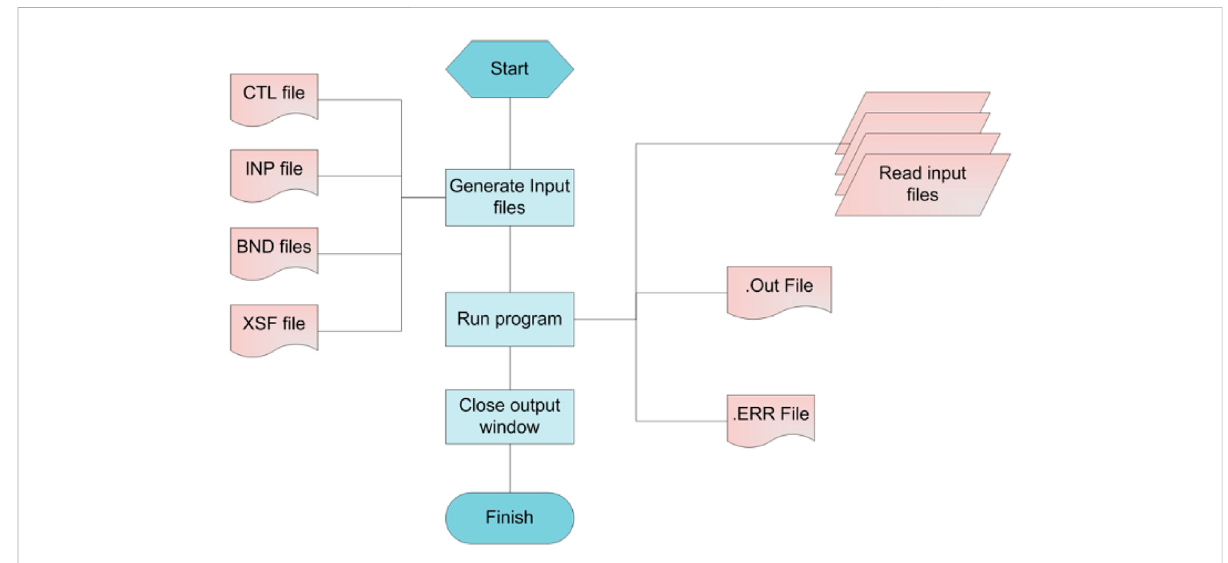
FIGURE 6 Running process of